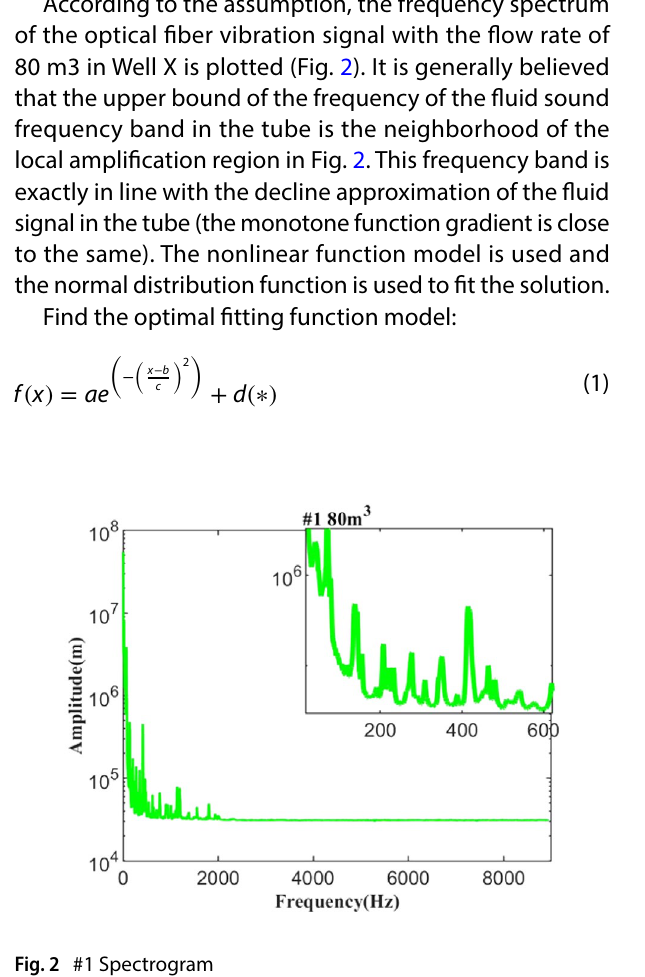
Fig. 2 #1 Spectrogram